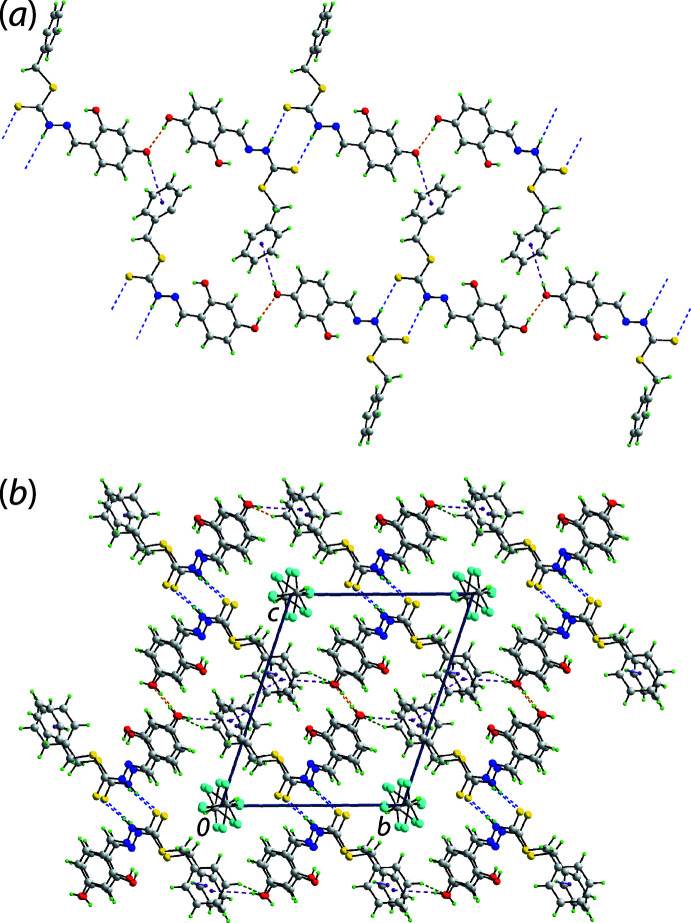
Mol­ecular packing in (I): (a) the linear, supra­molecular double-chain in which dimeric aggregates sustained by thio­amide-N—H⋯S(thio­amide) hydrogen bonding, shown as blue dashed lines, are connected by hydroxyl-O—H⋯O(hydrox­yl) (orange) and hydroxyl-O—H⋯π(phenyl) inter­actions (purple) and (b) a view of the unit-cell contents shown in projection down the a axis highlighting the three-dimensional framework and columns, parallel to the a-axis, in which reside the disordered CHCl3 mol­ecules. The phenyl-C—H⋯O(hydrox­yl) and phenyl-C—H⋯π(phen­yl) inter­actions are shown as green and pink dashed lines, respectively.